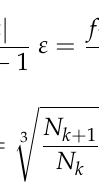
Figure 4. Grid independence validation of CHM.